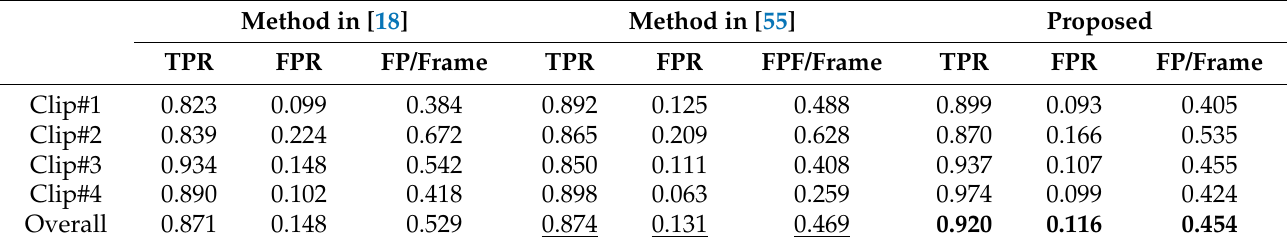
Table 3. Comparison of our approach with other lane detection algorithms. Method in